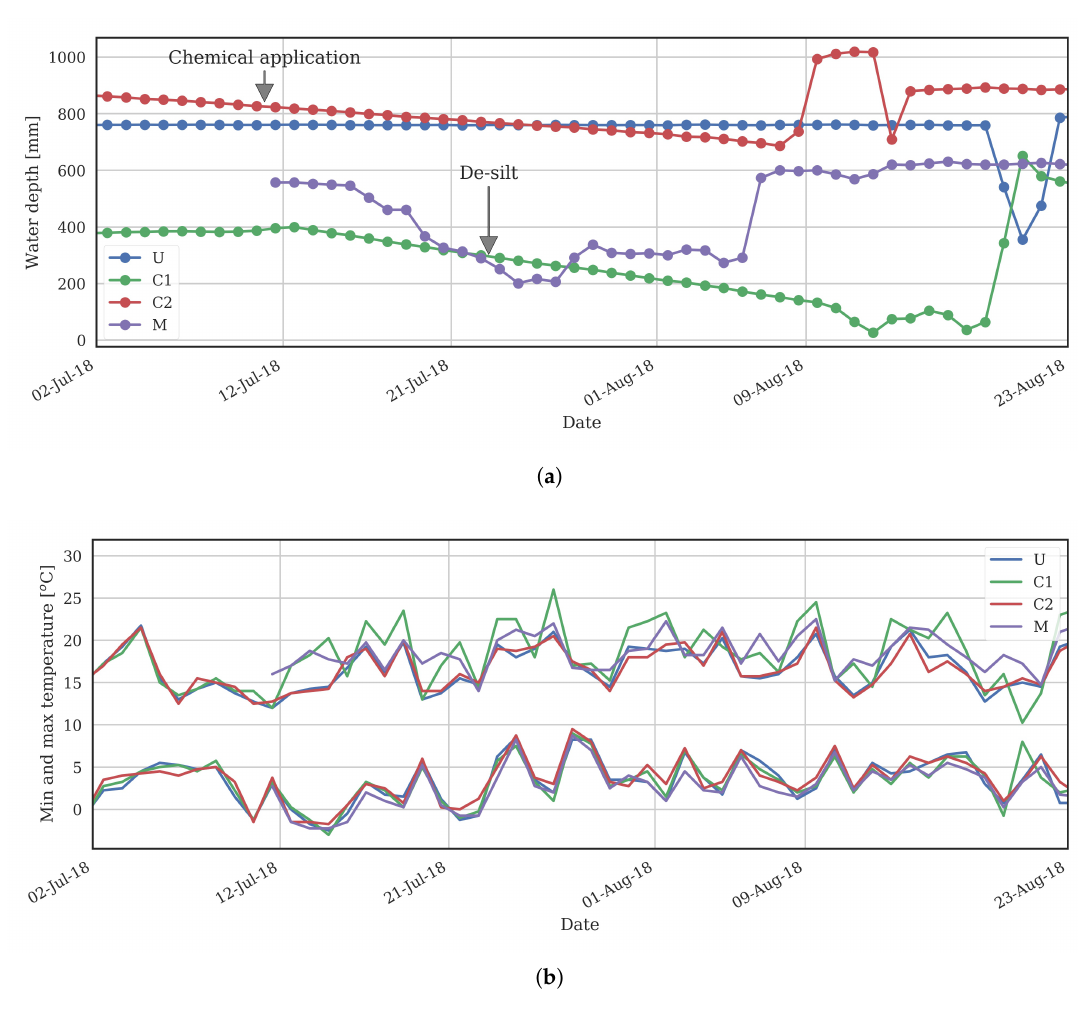
Figure 4. Logger data from each of the sites. ( a ) water depth with dates on which UAV images were taken indicated with vertical lines; ( b ) the minimum and maximum daily air